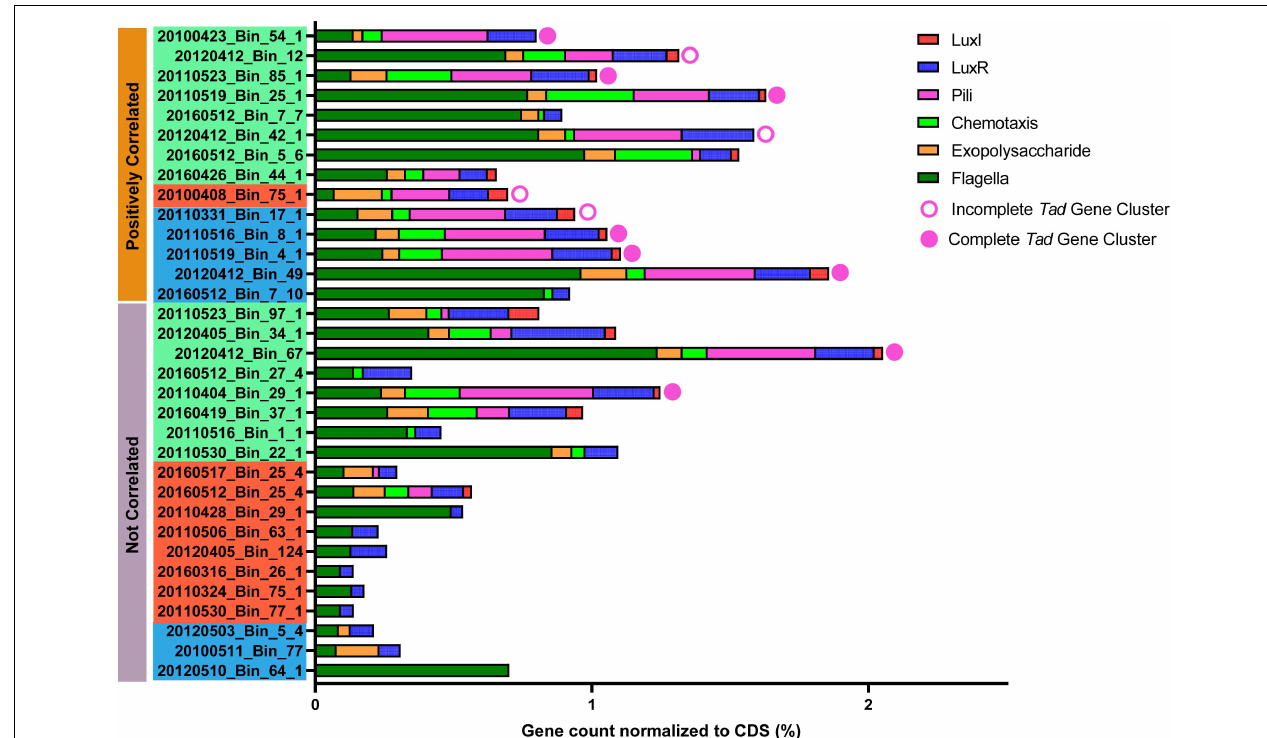
FIGURE 7 | Presence of genes/loci considered important for phycosphere colonization in Rhodobacterales MAGs. Gene counts were normalized against the number of coding sequences (CDS) in the respective MAGs. Solid circles indicate a complete tad gene locus, open circles indicate near-complete tad gene locus (Bins: 20120412_Bin_12, 20120412_Bin_42_1 and 20110331_Bin_17_1 are each missing 1 gene while 2010408_Bin_75_1 is missing 5 genes when compared to MAGs with a complete complement of tad genes), while the absence of circles indicate the complete absence of tad genes. Positively correlated MAGs are considered putative phycosphere colonizers and non-correlated MAGs are considered putative generalists as established in Figure 5 . Color coding of MAG names indicate the MAG grouping based in Figure 3 .